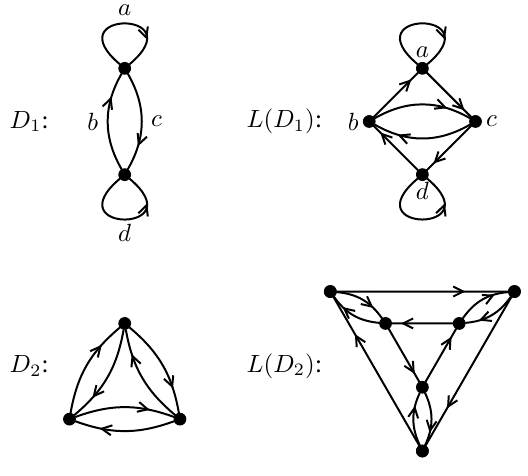
Figure 2: Examples of relations.